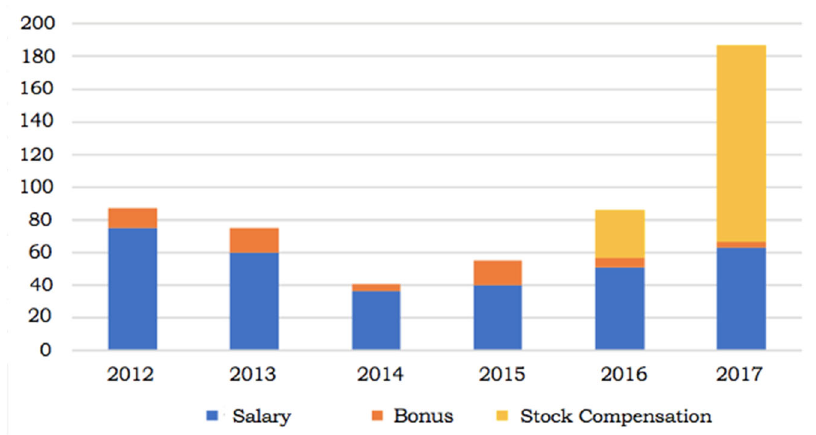
Figure 4. Classified average executive compensation in Softbank Note: Vertical axis indicates the amount of average executive compensation and horizontal axis indicates fiscal year.